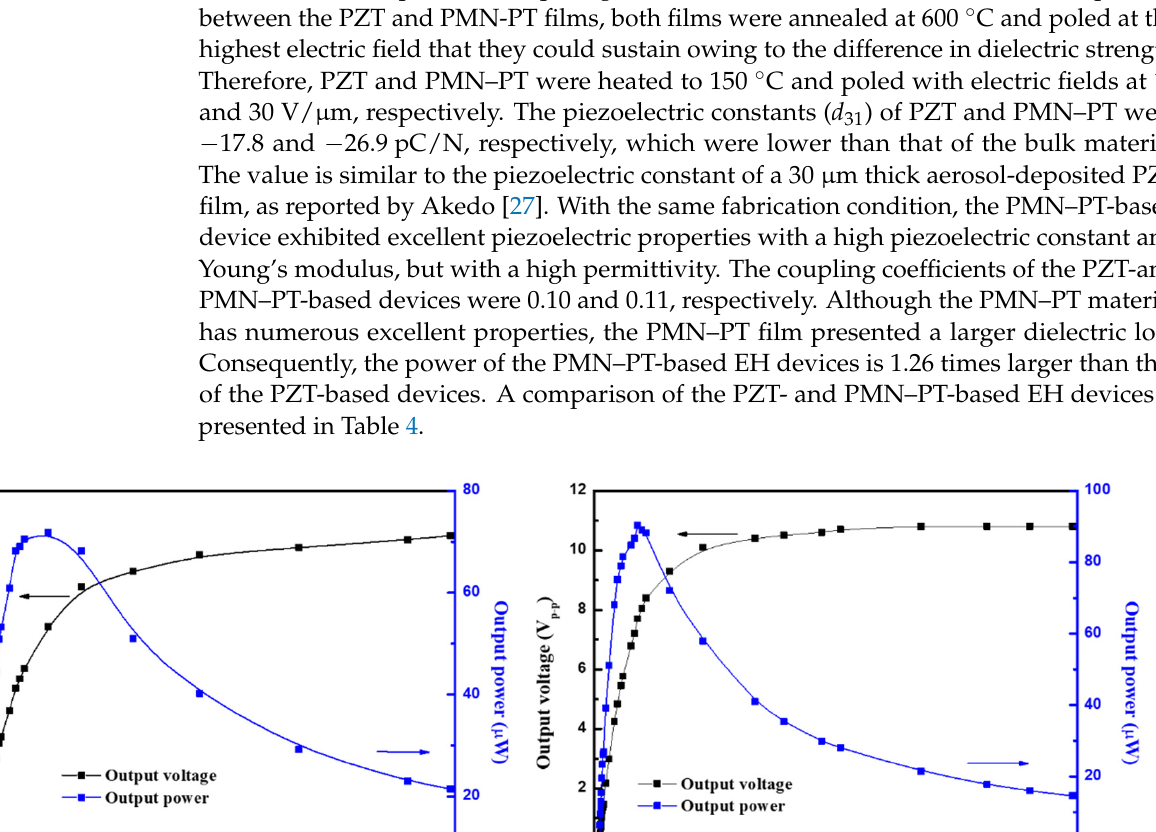
Figure 9. ( a ) PZT and ( b ) PMN–PT device electrical output vs. load impedance at the 0.5 g acceleration level.